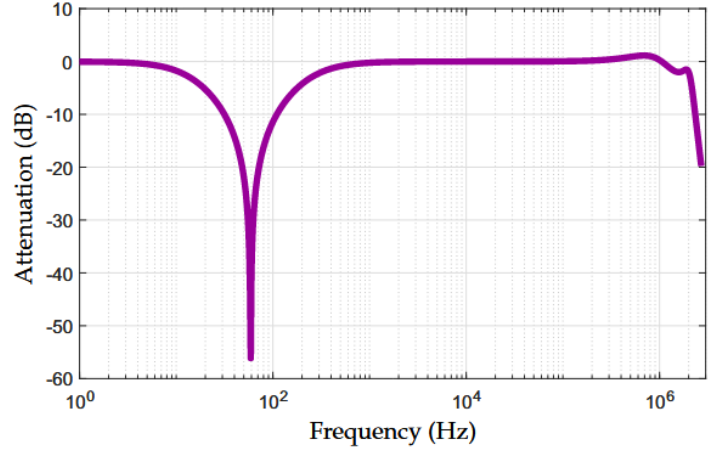
Figure 4. Attenuation of the simulated NB–PLC notch coupling circuit.